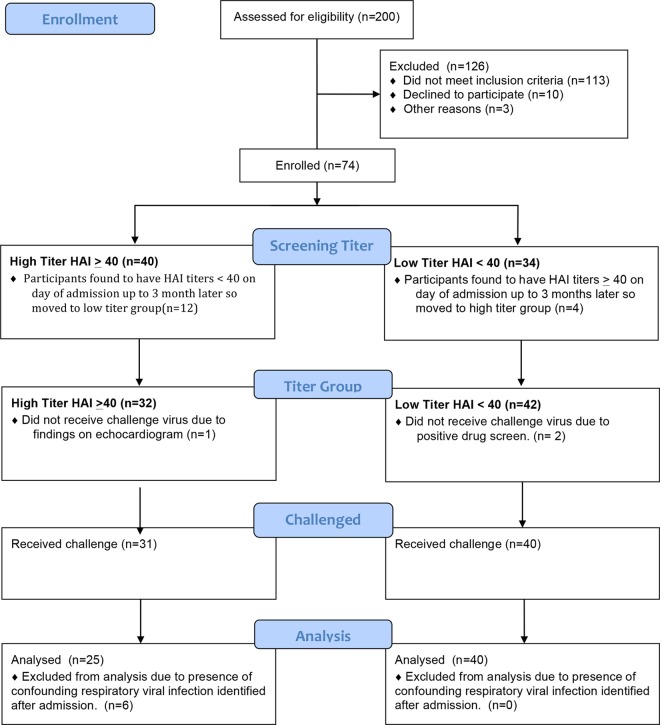
Study flow chart. A total of 200 volunteers were screened for participation. Of these volunteers, 74 were enrolled in the study with 40 in the high-HAI-titer group and 34 in the low-HAI-titer group up to 3 months prior to challenge. On admission for challenge, 16 participants were found to have HAI titers that had increased or decreased since the time of screening either due to waning titers or exposure to virus. Three participants were excluded prior to challenge for safety reasons. Thirty-one participants on the high-titer group and 40 participants in the low-titer group were challenged, and 6 participants in the high-titer group were excluded from the analysis due to detection of another respiratory viral infection within 48 h of challenge.